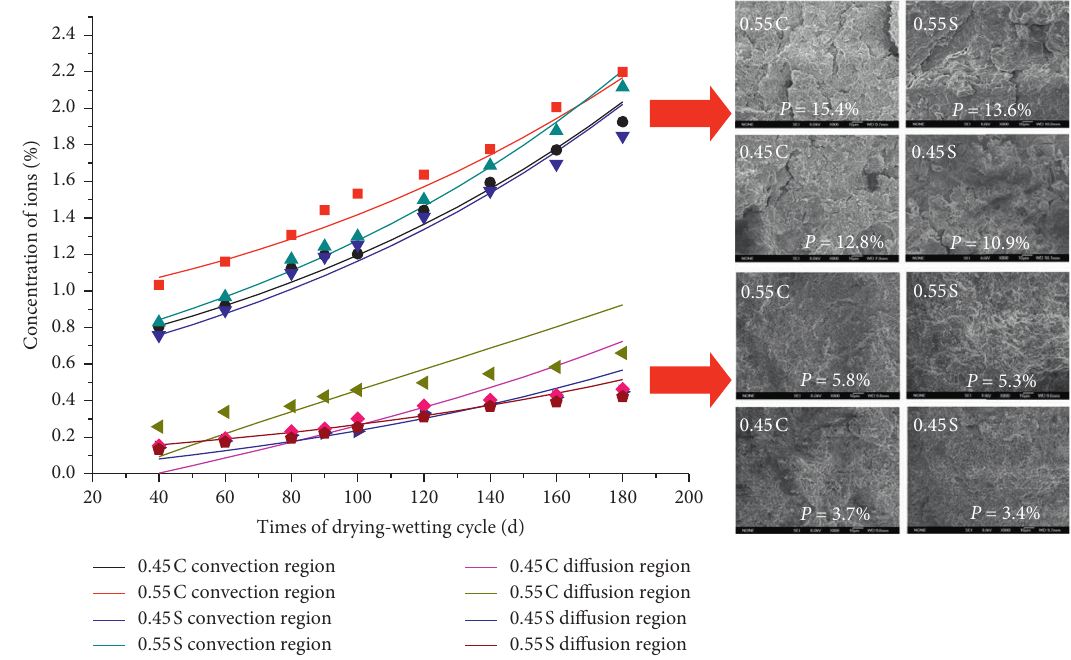
Figure 7: Relationship between the concentration of ions and the times of drying-wetting cycle and relative region microstructure photos of